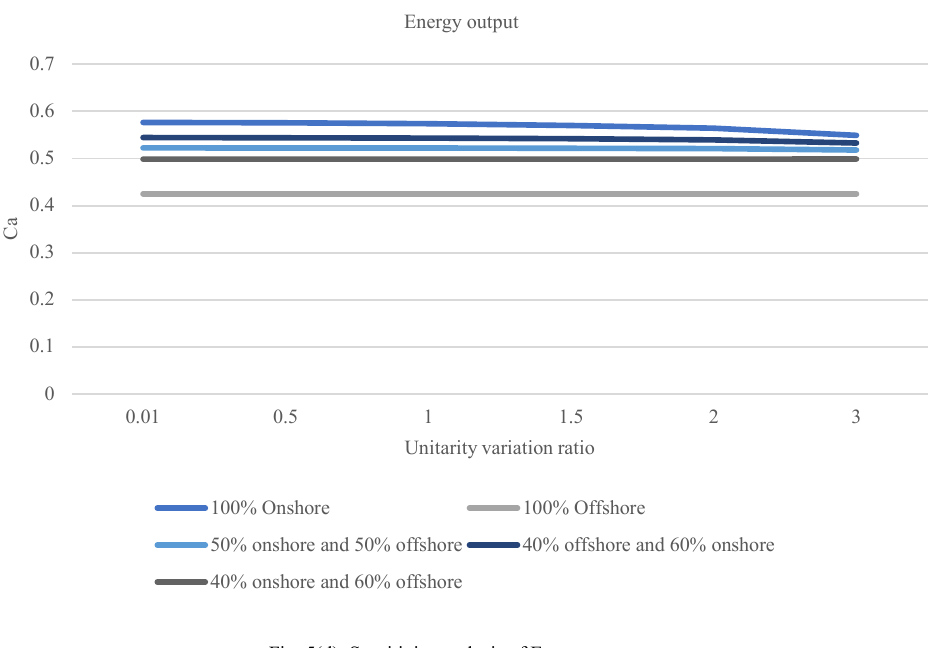
Fig. 5(d). Sensitivity analysis of Energy output .